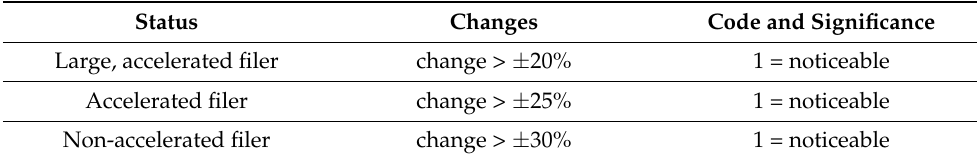
Table 1. “Audit Fees-Significant Change” index. Status Changes Code and Significance Large, accelerated filer change > ± 20% 1 = noticeable Accelerated filer change > ± 25% 1 = noticeable Non-accelerated filer change > ± 30% 1 = noticeable Source: own